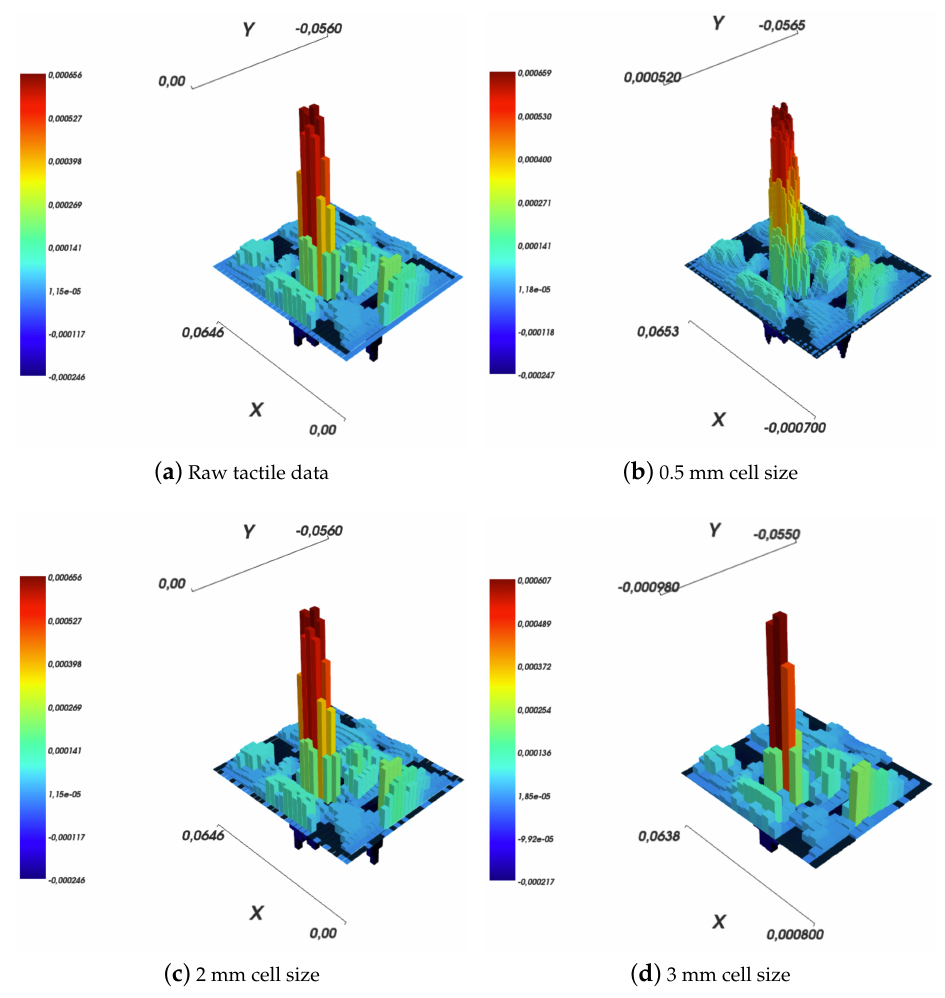
Figure 13. Reconstruction of surface deflections according to Love’s solution with a varying resolution of the reconstruction